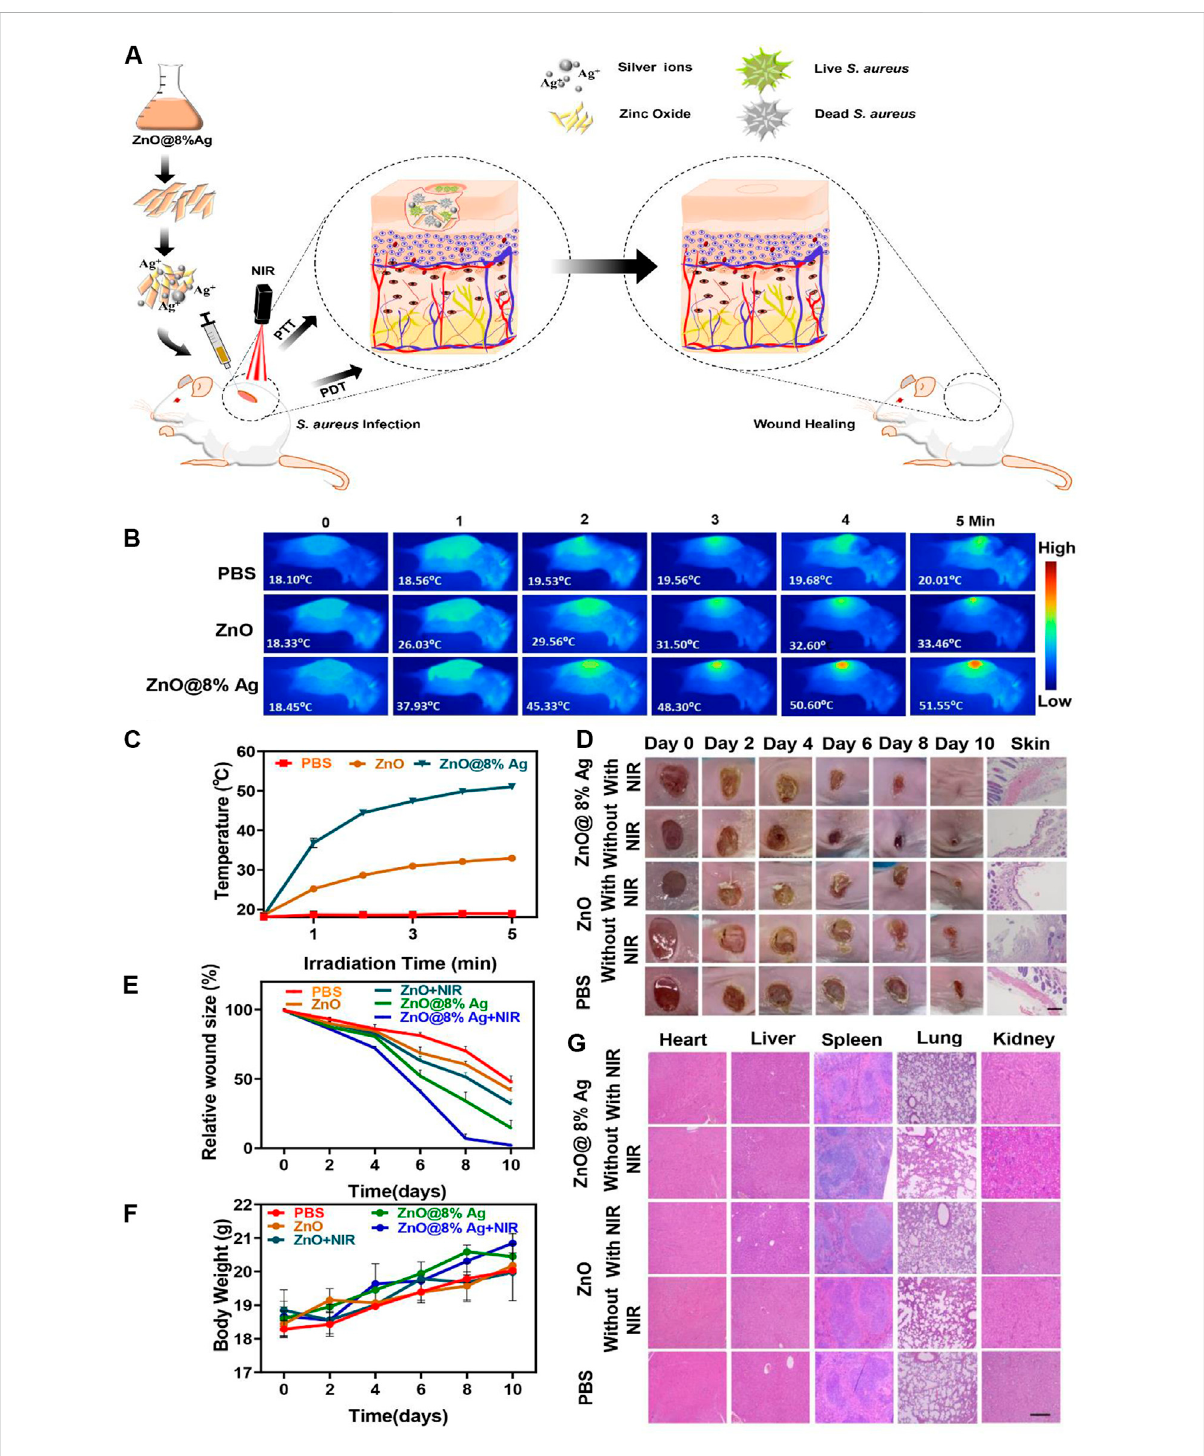
FIGURE 7 In vivo antibacterial activity of ZnO@8%Ag. (A) Schematic illustrationof the fabricated ZnO@8%Ag and the corresponding antibacterial effect in vivo underPTT and PDT, (B) thermal images of PBS,ZnO, and ZnO@8%Ag underNIR irradiation (808 nm,2 W/cm 2 , 5 min), (C) temperature variation curve corresponding to (B) , (D) representative images of S.aureus infectedwound after treatment, (E) quantitative curve of thewound size over time for the treatment groups, (F) bodyweight variation curve for the different treatment groups over time, and (G) tissue slices of major organs (the heart, liver, spleen, lung and kidney) stained with H&E, after treatment, scale bar 100